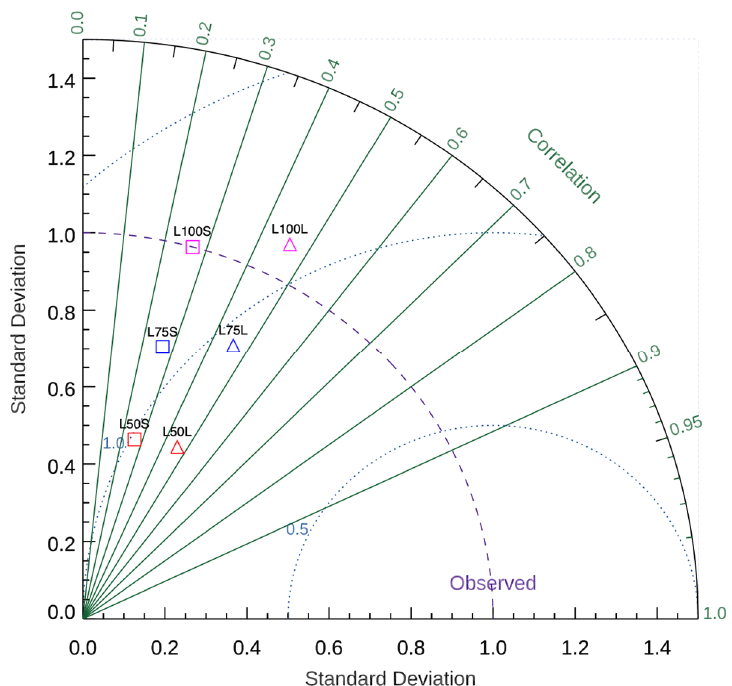
Figure 8. Taylor diagram for the 162 cases studied and each configuration of the DLS. The number of 48 km grid cells classified as sea and land is 44,712 and 34,930, respectively. The cells containing an equal amount of WRF 3 km grid cells labelled as land or sea were discarded from the analysis. L50S is the result for L50 over the sea, L50L is the results for L50 over the land; L75S is the result for L75 over the sea, L75L is the result for L75 over the land; L100S is the result for L100 over the sea, L100L is the result for L100 over the land.